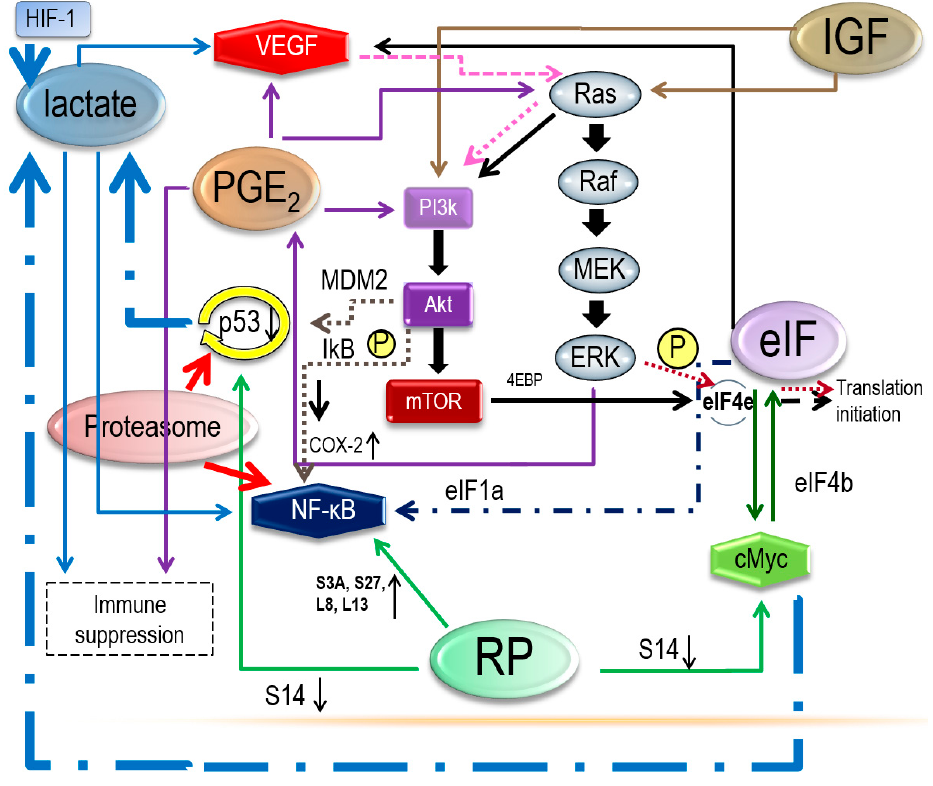
Figure 2. Associations between ribosomal proteins, eukaryotic translation initiation factors, lactate, prostaglandin, proteasome, and insulin-like growth factors, as detailed in the Discussion section. PI3K/Akt/mTOR is often activated in malignancies, and the Ras/Raf/MEK/ERK signaling